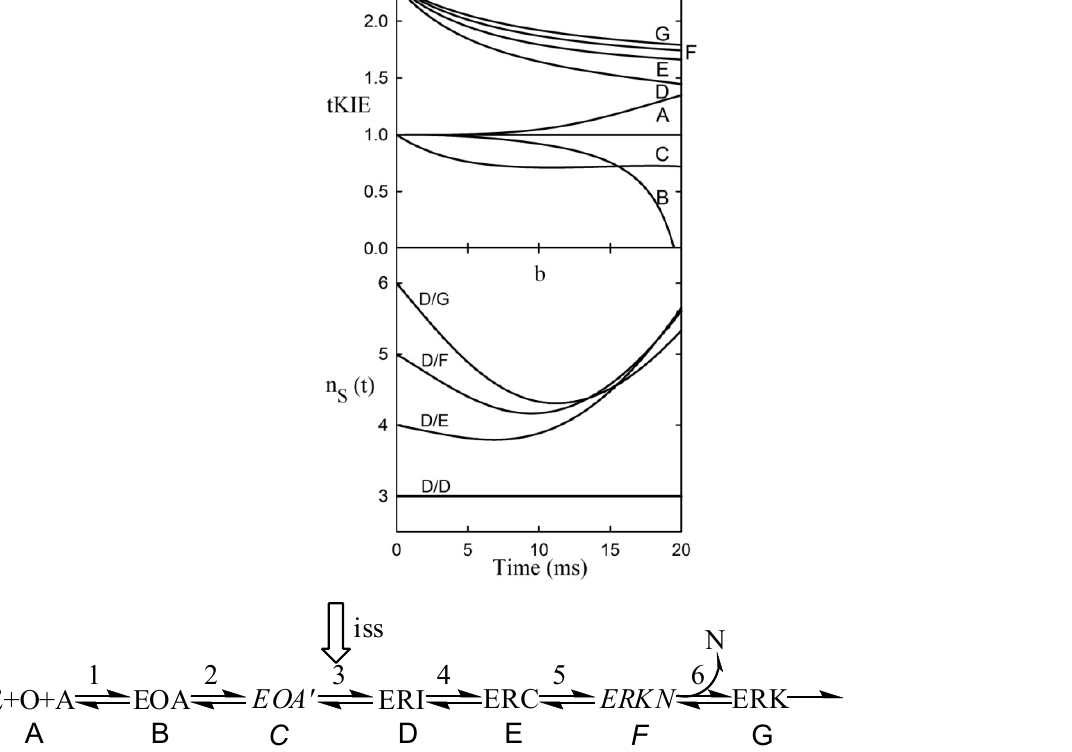
Figure 7. Application of the First and Second Rules to the PheDH reaction. ( a ) Application of the First Rule-time courses of tKIEs of the reaction components assuming the six-step mechanism of Equation (11). ( b ) Application of the Second Rule using the n values calculated from the fitted curves of panel s